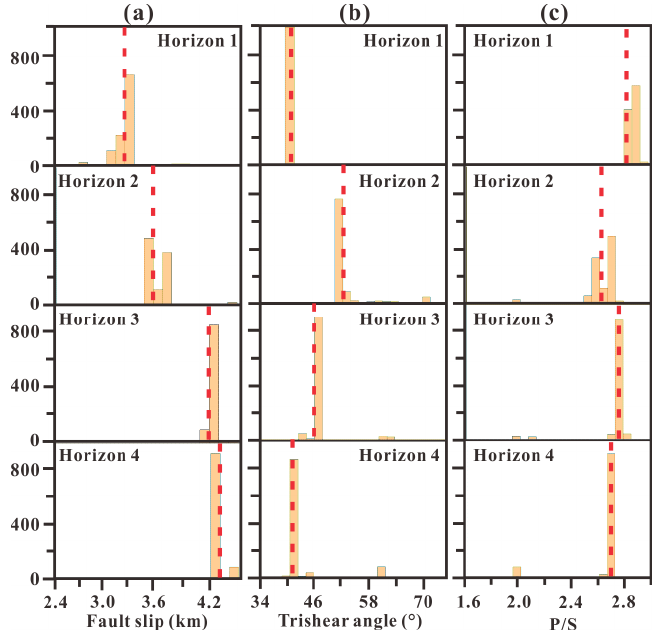
Figure 13. The inversion results of horizons 1–4 in Figure 10b show the distributions of the ( a ) Fault slip, ( b ) Trishear angle, and ( c ) P/S ratio. Red dashed lines indicate the values of best-fit parameters acquired from inverse modeling. See the text for a detailed analysis.